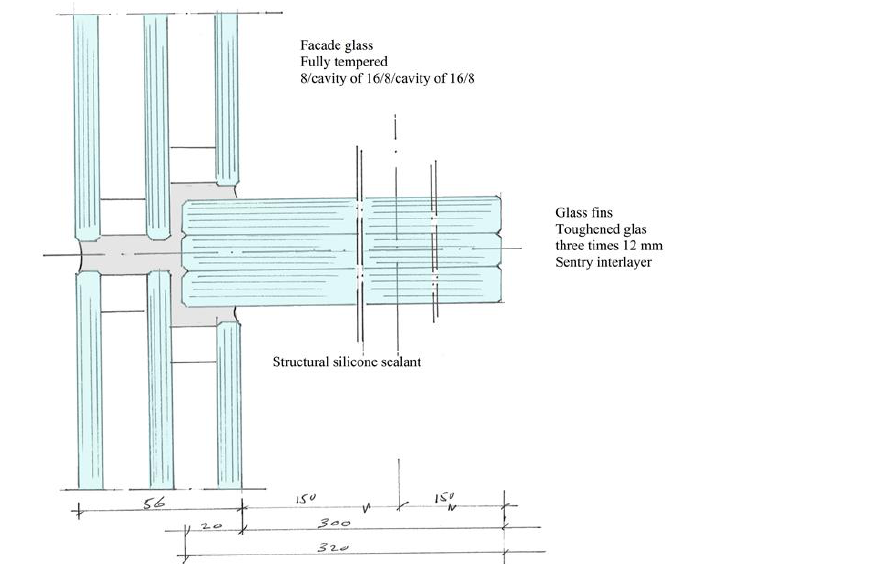
Fig. 4 horizontal section of connection fin and façade glass in the first